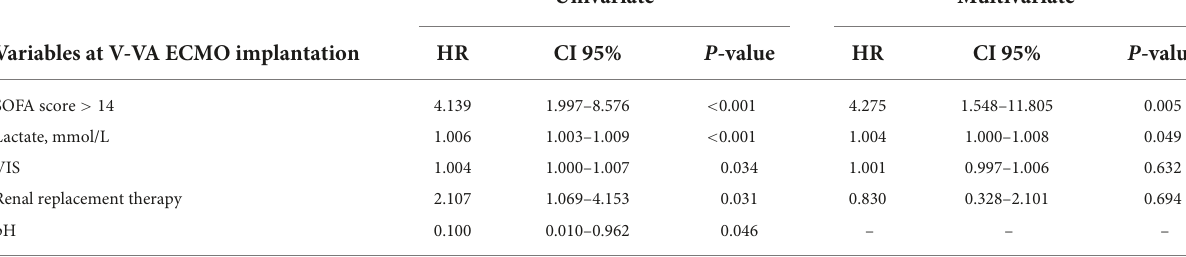
TABLE 5 Cox proportional-hazards model for 60-day intensive care unit-mortality. Univariate